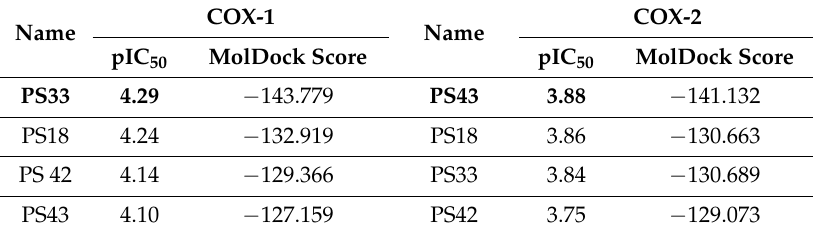
Table 4. Selected docking results sorted by biological activity for COX-1 and COX-2,